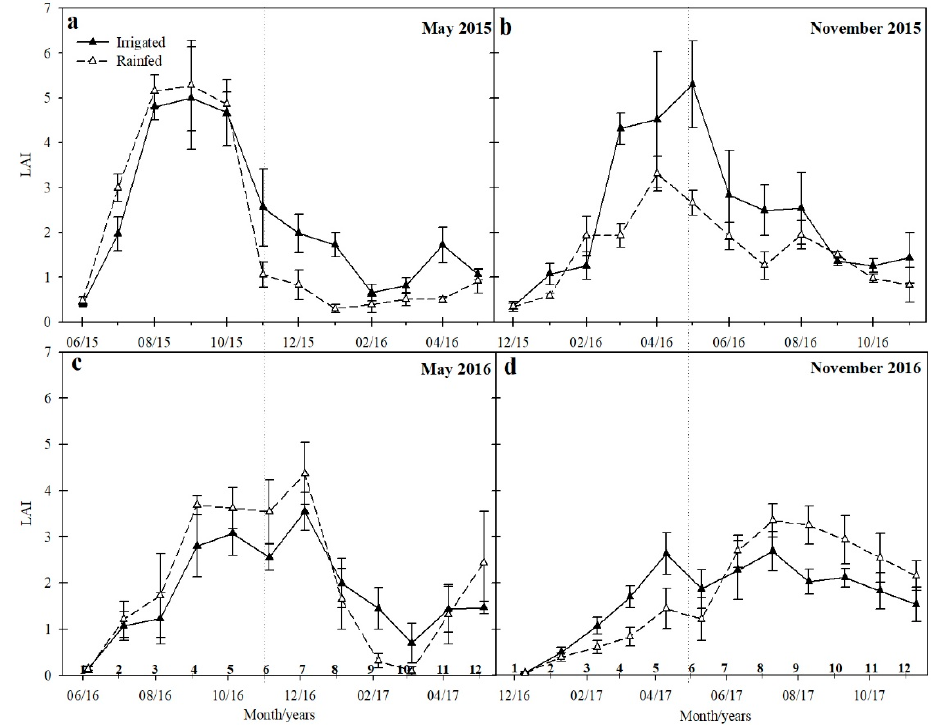
Figure 4. Leaf area index of Rayong 9 cassava under irrigated and rainfed conditions after planting in ( a , c ) May and ( b , d ) November 2015 and 2016. The bar is standard deviation .